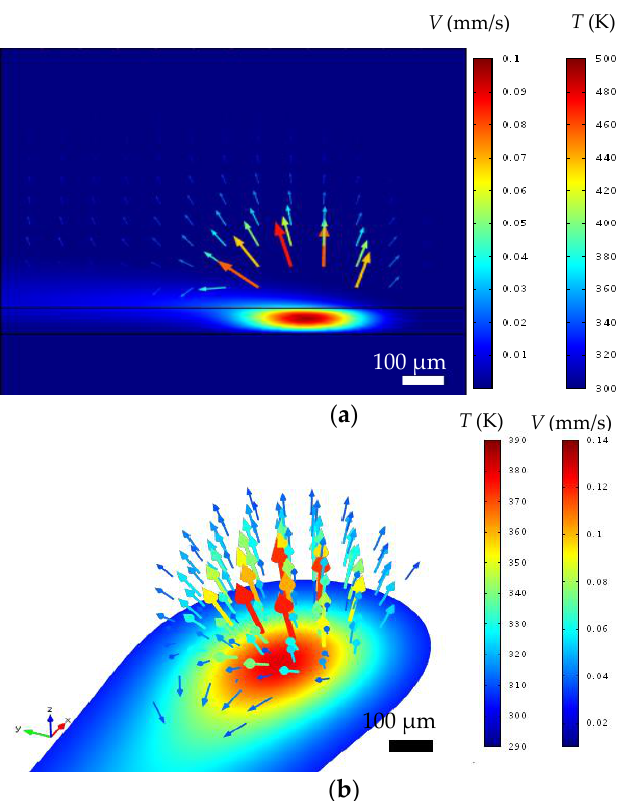
Figure 10. The velocity (arrows) and temperature (color surface) distribution near the laser focal spot, ( a ) Side view; ( b ) 3D